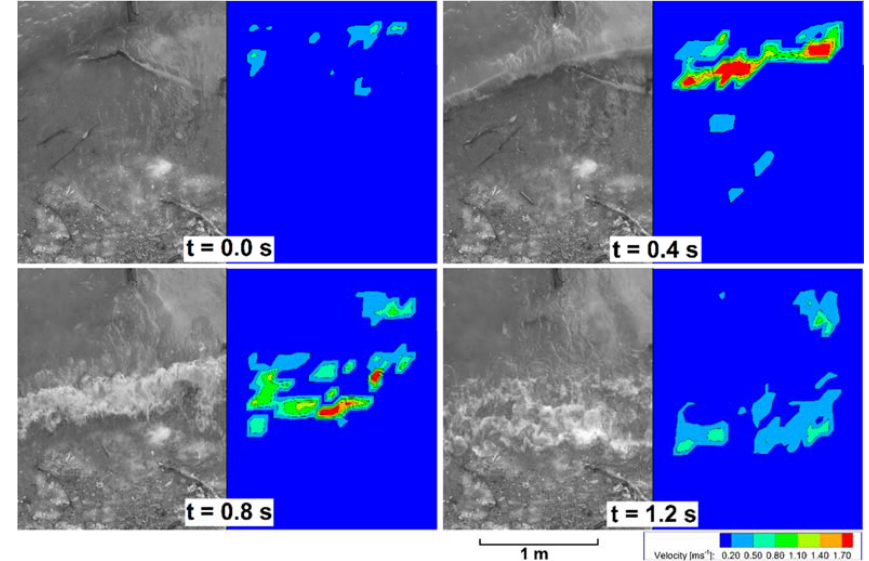
Figure 12. A series of orthorectified video frames at an interval of dt = 0.4 s; surface velocity fields calculated with LSPIV for the same frames.